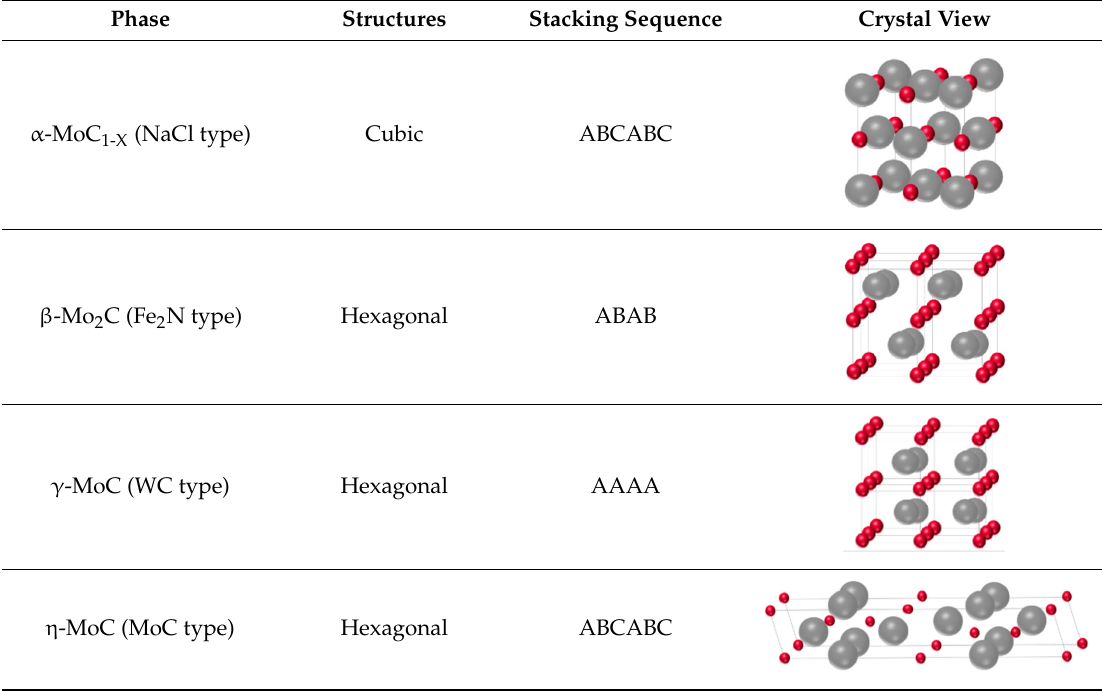
Table 1. information of four phase of molybdenum carbide adapted with permission from [64].